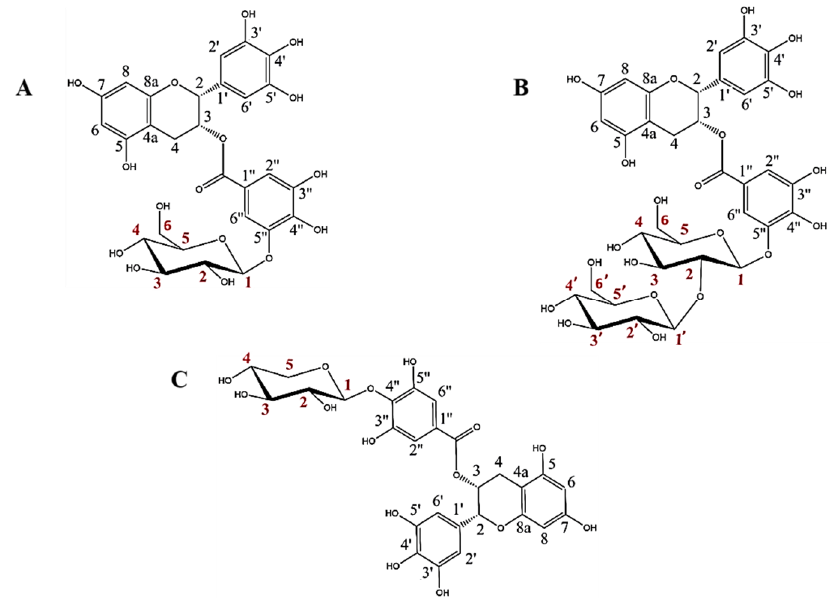
Figure 1. Structures of the three EGCG glycosides studied in this work: ( A ) epigallocatechin gallate 5”-O-β- D -glucopyranoside, ( B ) epigallocatechin gallate 5″-O-β- D -sophoropyranoside, and ( C ) epi- gallocatechin gallate 4″-O-β- D -xylopyranoside (adapted from Méndez-Liter et al. [19] and Nieto- Domínguez et al. [18]). Every C atom in the molecules is numbered in black for EGCG and in red for the glucose, sophorose and xylose motifs.